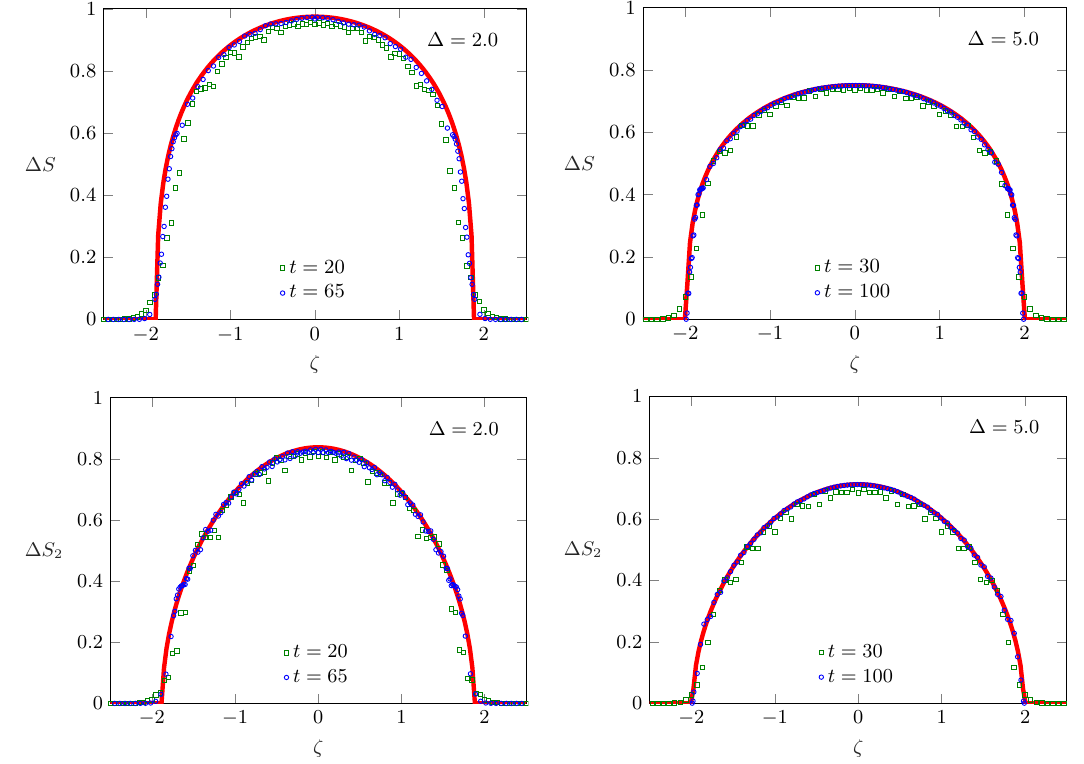
Figure 8: Entropy profiles ∆ S (top) and ∆ S ˜ m for two different values of ∆ and L = 400. The solid lines show the ansatz Eq. (62) 1 for the von Neumann, as well as Eq. (63) for the n = 2 Rényi excess